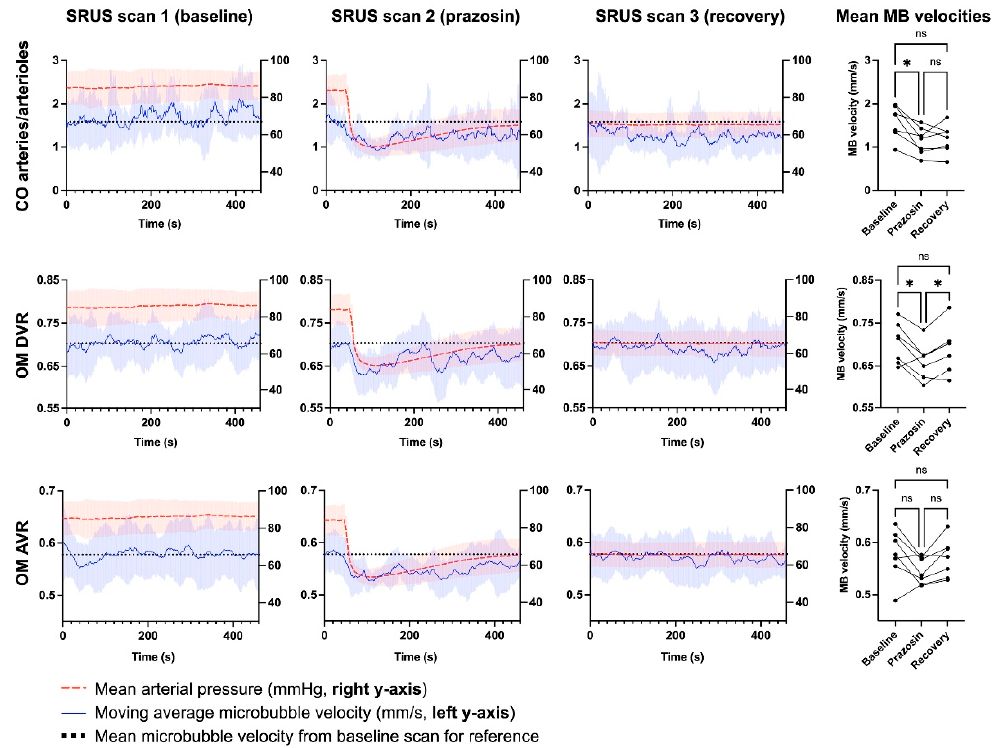
Figure 6. Moving average MB velocities shown together with the mean arterial pressure. Semisolid areas represent the standard deviation. The black dotted line indicates the mean MB velocity from SRUS scan 1 for an easier immediate visual comparison in SRUS scans 2 and 3. The scatter plots on the right show the mean MB velocities from the raw data of the three scans. The asterisks indicate the result of Tukey’s post-hoc test. * = p ≤ 0.05, ns = non-significant ( p > 0.05).